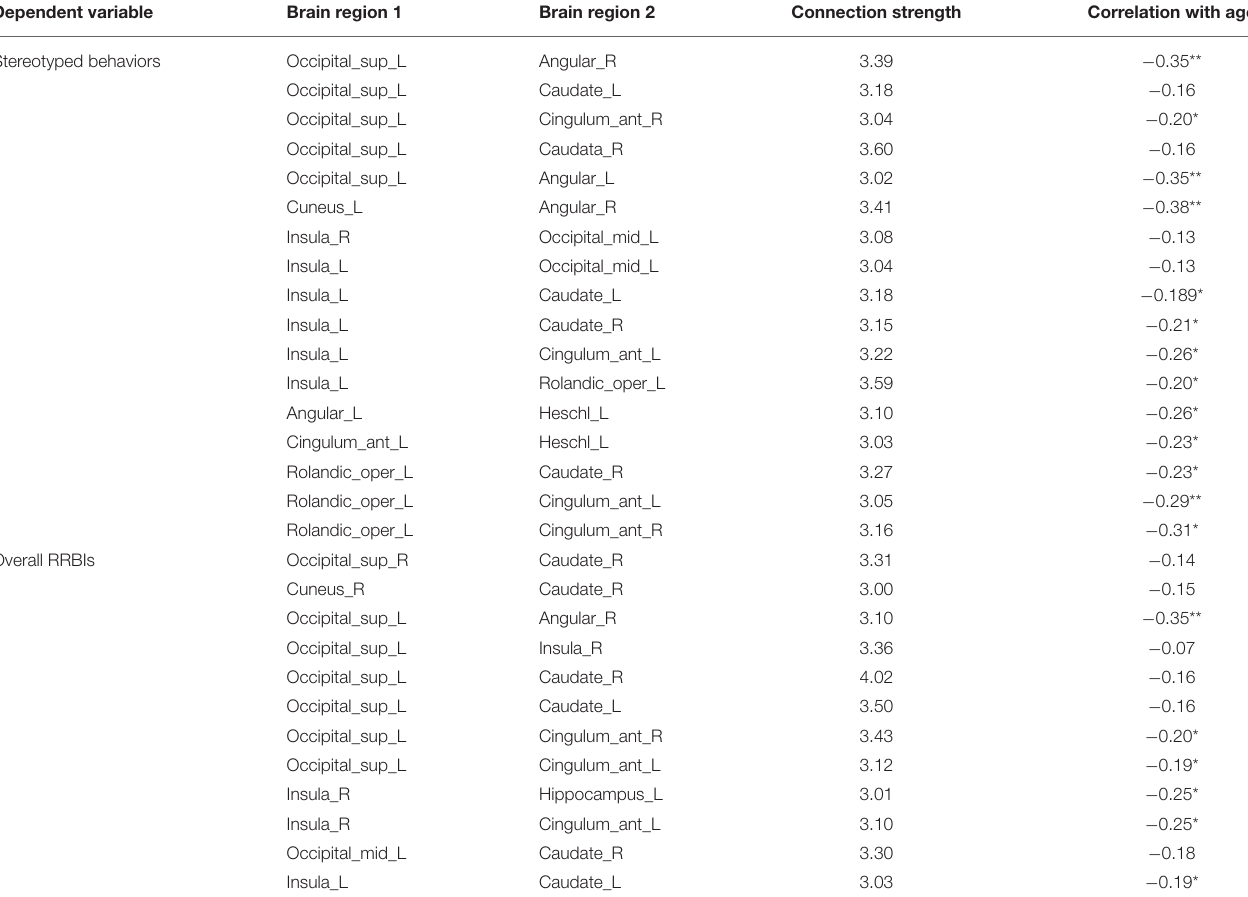
TABLE 4 | Functional connectivity associated with stereotyped behaviors and overall RRBIs and correlation between FC and age ( n = 147). Dependent